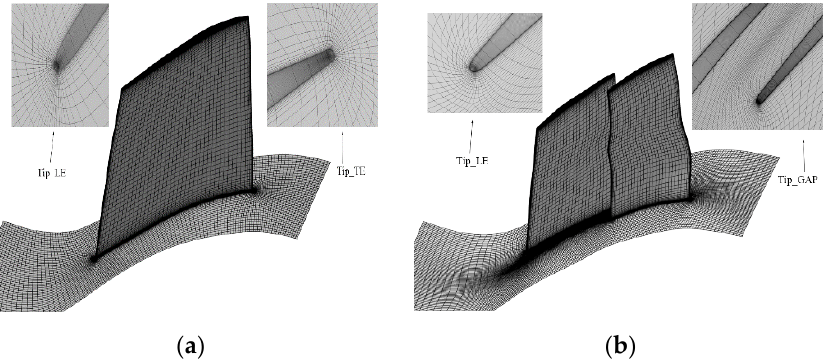
Figure 4. The final computational grid of Rotor37 and the original tandem rotor. ( a ) Rotor37; ( b ) ORG.